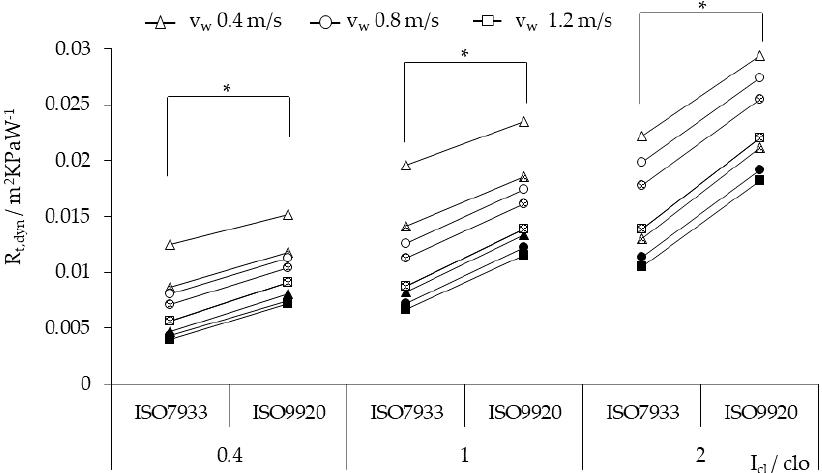
Figure 2. The dynamic evaporative resistance of three types of clothing calculated by two correction algorithms, ISO 7933 and ISO 9920, with empty spots for v a = 0.5 m / s, partially filled for v a = 1 m / s, and fully filled for v a = 3 m / s. * p < 0.05.